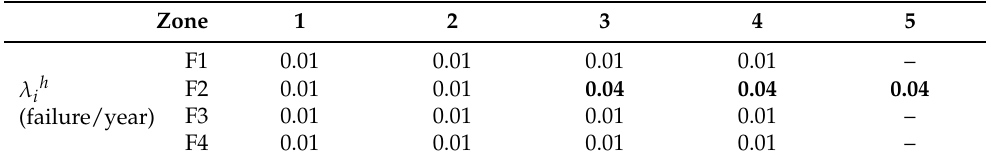
Table 2. Historical failure rates per zone.